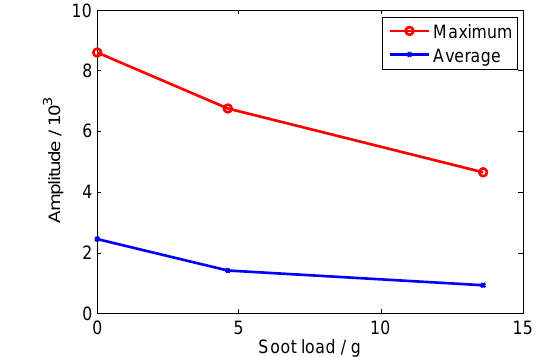
Figure 12. UWB magnitude spectrum for three different DPF load- ing states corresponding to the time-domain signals in Fig. 4.